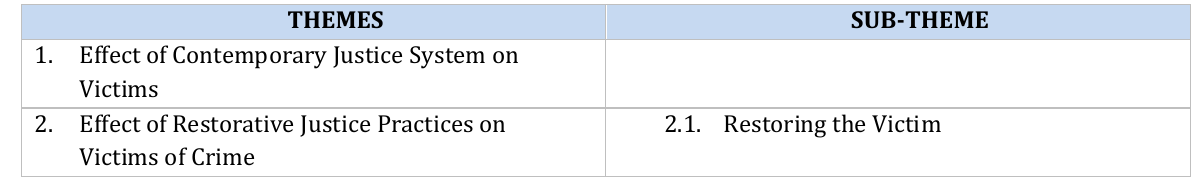
Table 2. Themes and